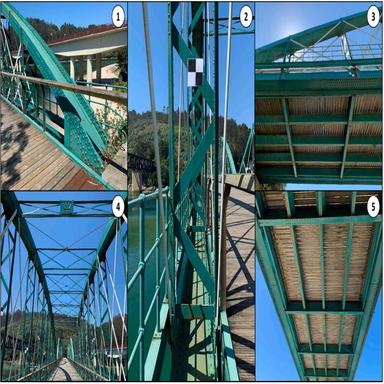
Details of O Barqueiro Bridge: (1) arch rib (2) vertical hanger (3) stringers (4) sway systems (5) crossbeams.